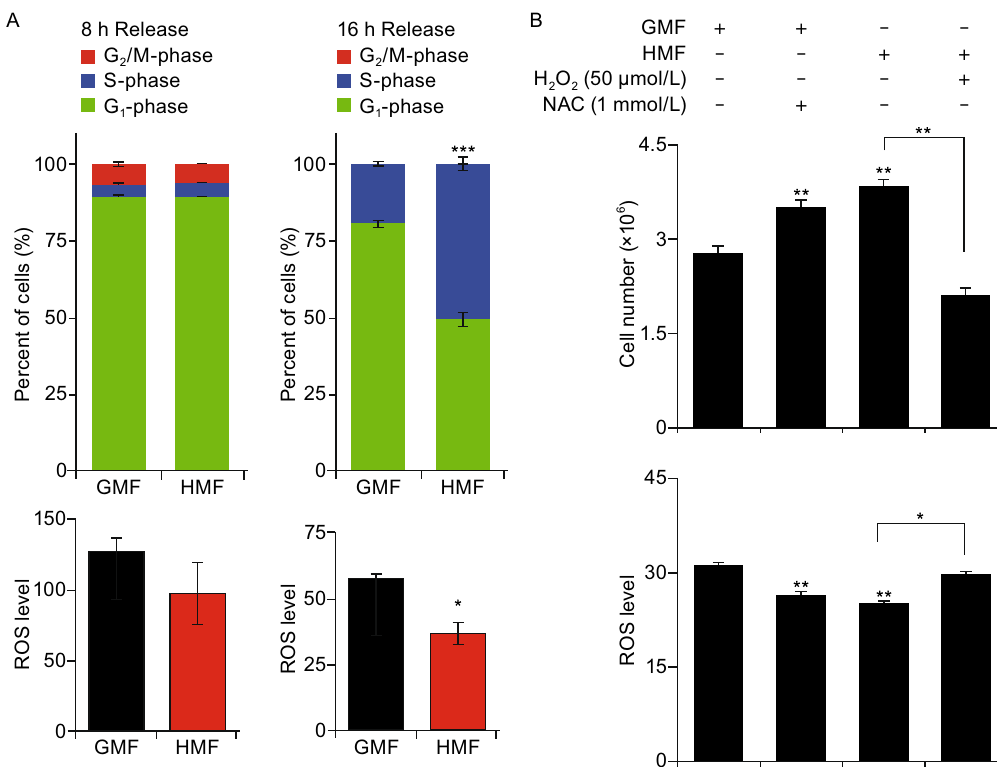
Figure 2. H 2 O 2 rescues HMF-accelerated cell proliferation by elevating cellular ROS level. (A) HMF stimulates G 1 /S transition accompanied with reduction in ROS level. Most G 1 -phase synchronized SH-SY5Y cells remained at G 1 -phase after 8 h releasing and the ROS level was the same between the HMF and GMF group. More HMF-exposed cells entered S-phase, after 16 h releasing; and the ROS level reduced in the HMF group. (B) Reducing the cellular ROS level by 1 mmol/L NAC mimics the HMF-accelerated cell proliferation in the day 2 HMF-exposed non-synchronized cells. Addition of 50 μ mol/L H 2 O 2 in the HMF condition rescues the